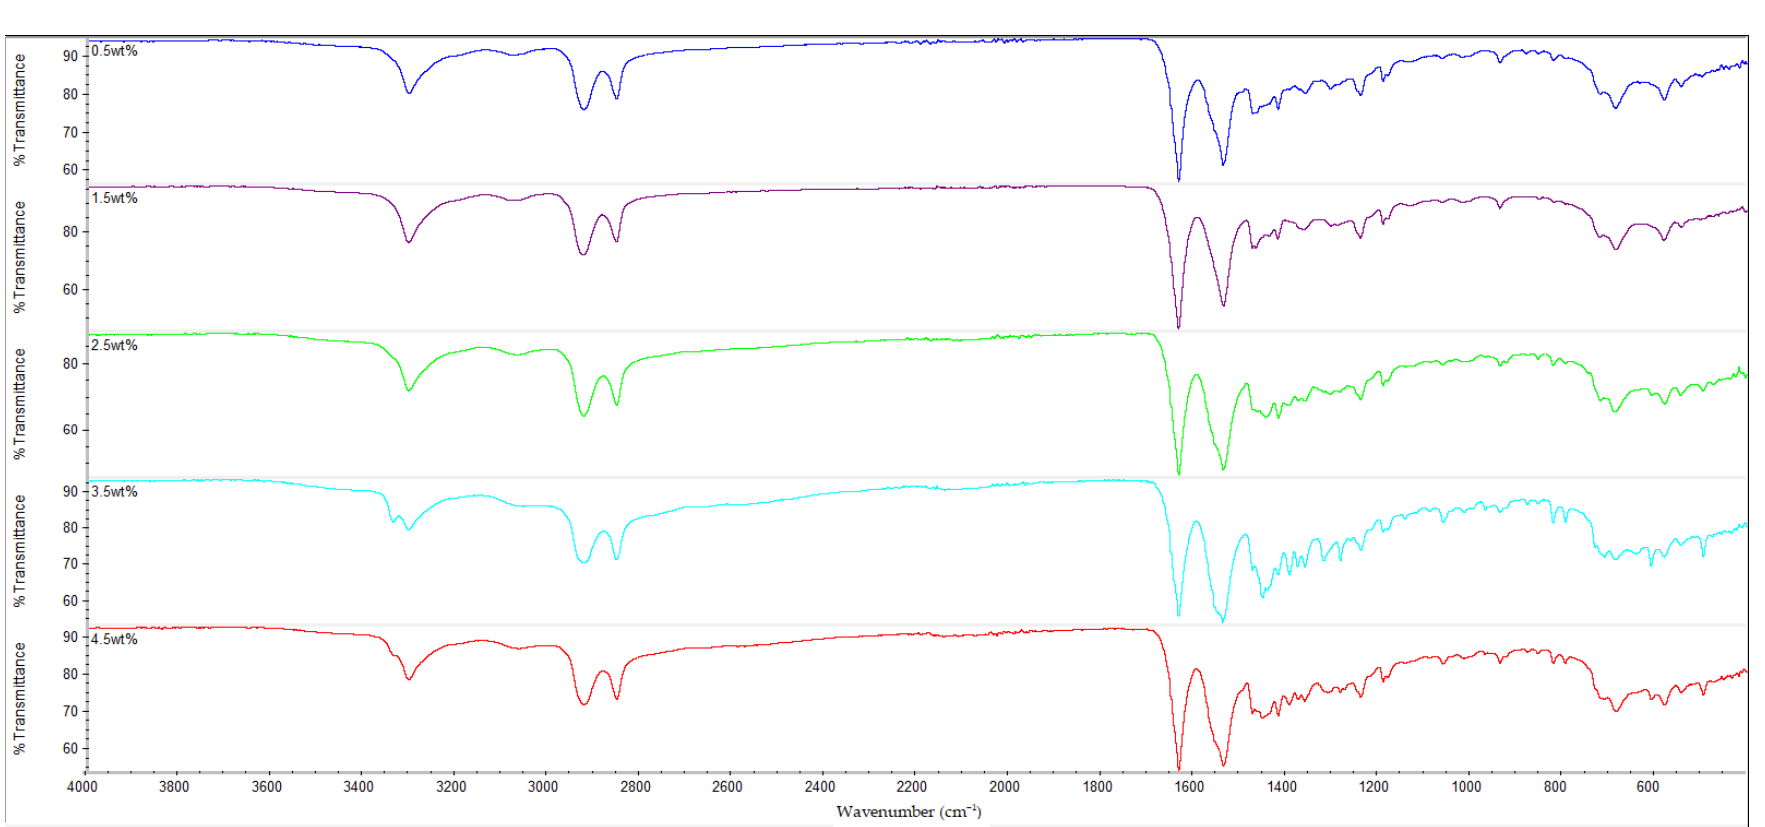
Figure 11. FTIR Spectra for Nylon 610 Nanocomposites with Treated Graphite Flakes at 175 °C and − 0.08 MPa.